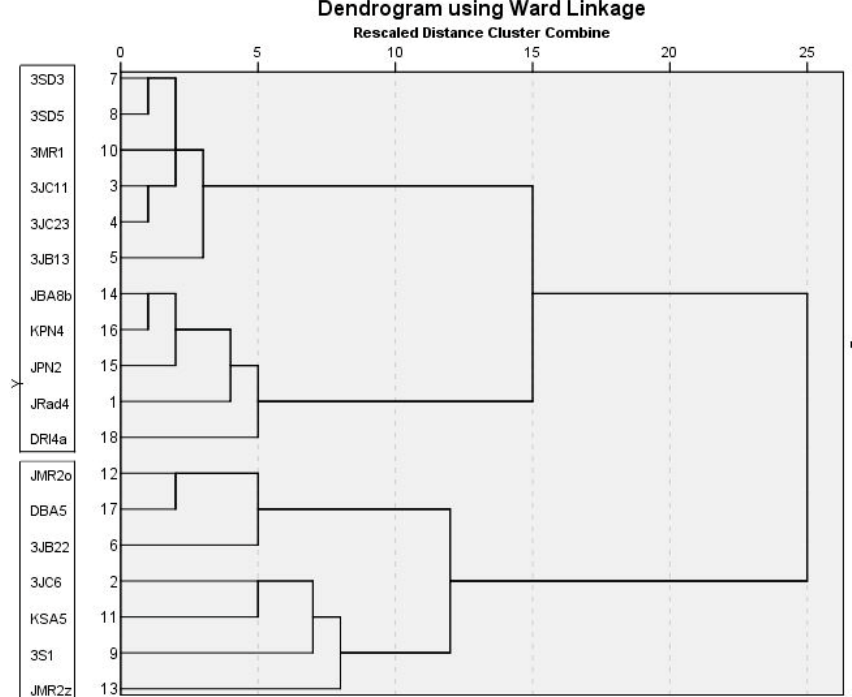
Figure 5. Dendogram showing grouping of Penicillium crustosum isolates based on colony diameter on different media (PDA, MEA, CYA, and YES), using Ward’s model with Euclidian Distance in- terval. P. crustosum isolates within a clade are indicated in black boxes.